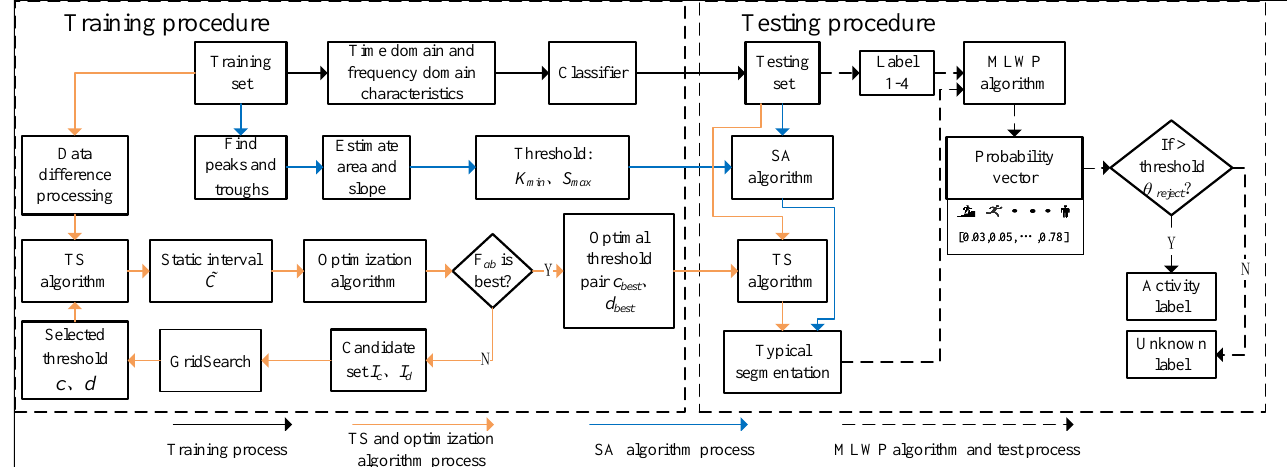
Figure 3. Framework diagram of the proposed scheme.